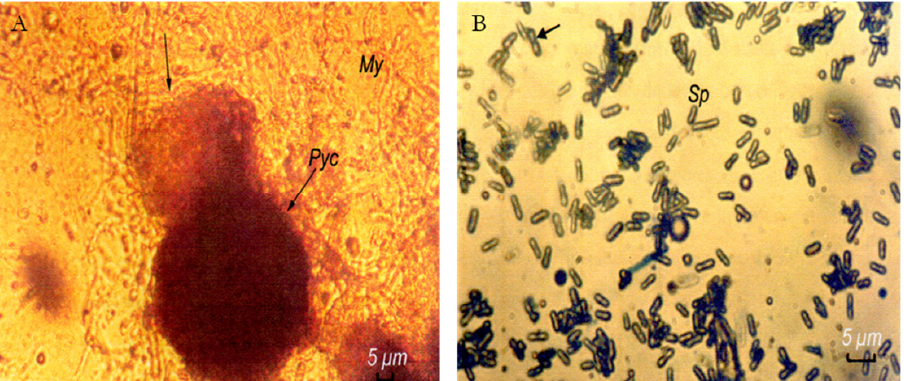
Figure 1. Microscopic features of Ascochyta rabiei : (A) mature pycnidia with cirrus release; (B) single and bicellular pycnidiospores of Ascochyta rabiei Pyc: pycnidia; My: mycelium; Sp: